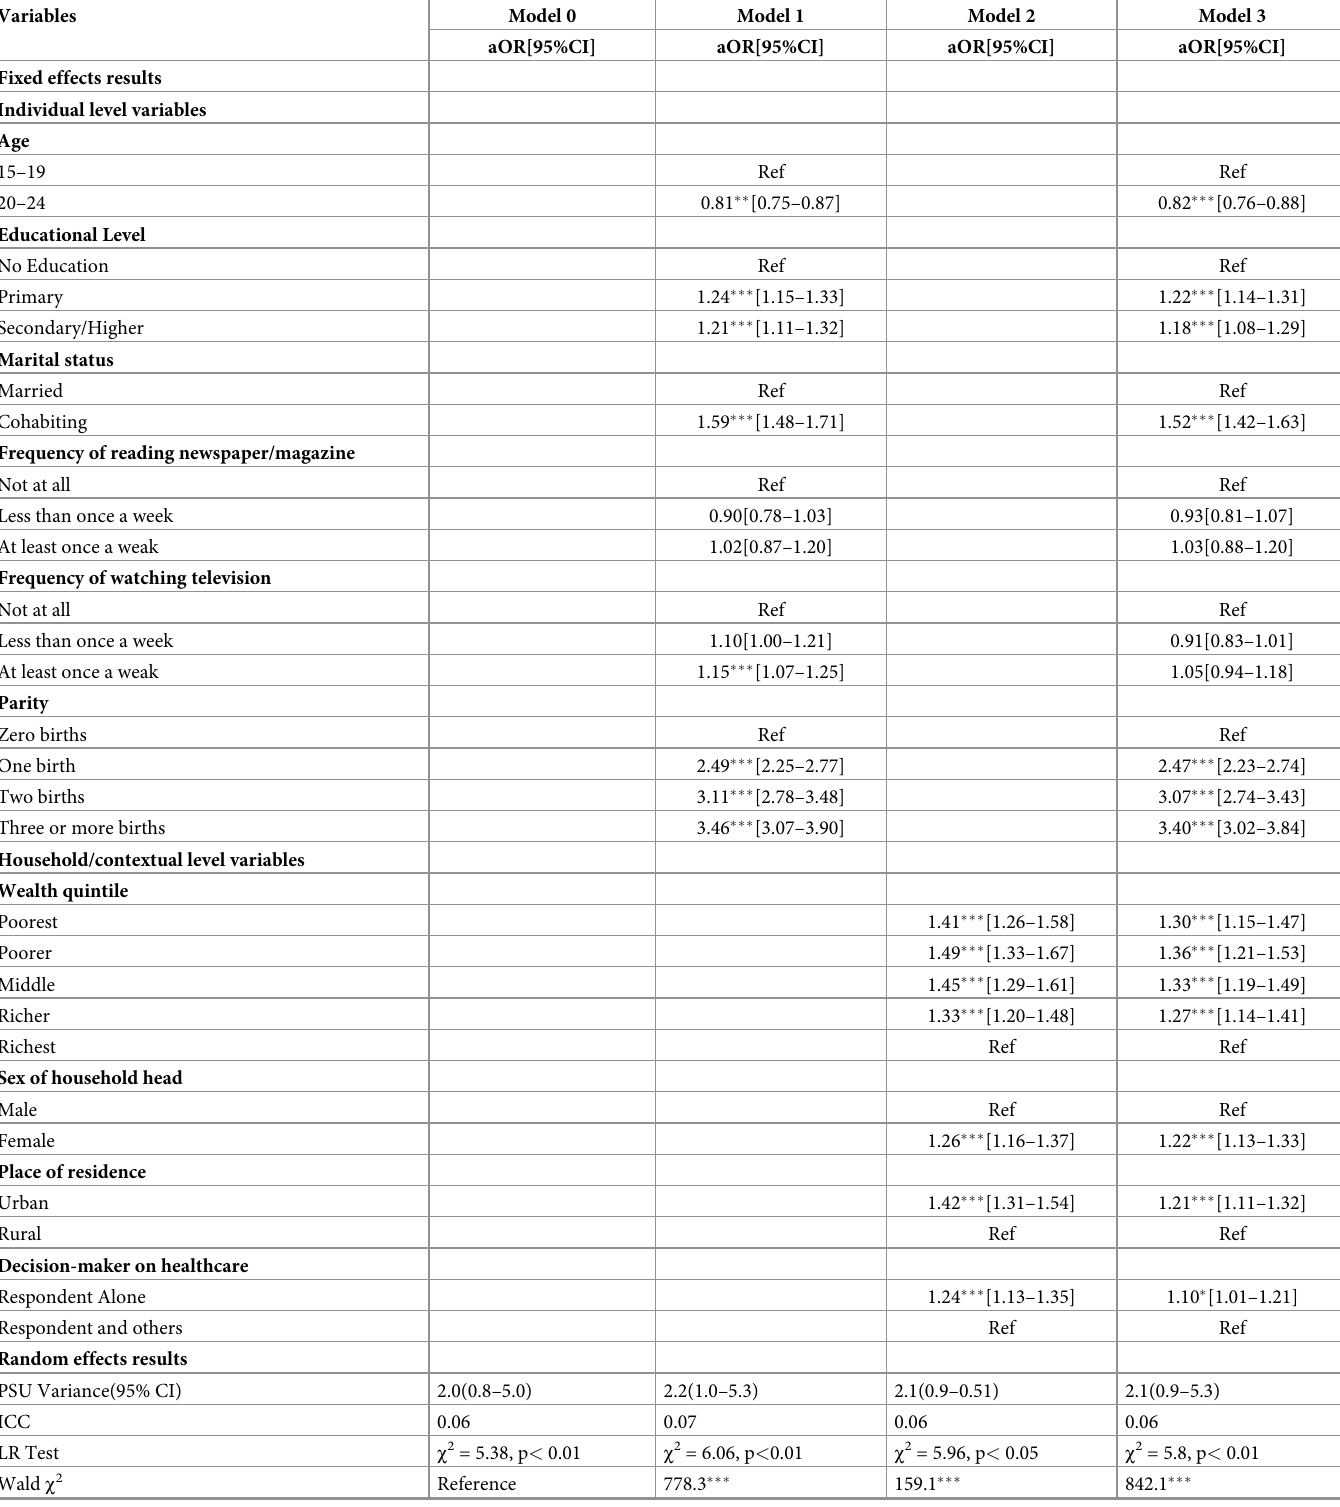
Table 3. Multilevel logistic regression models for individual and household/community predictors of unmet need for